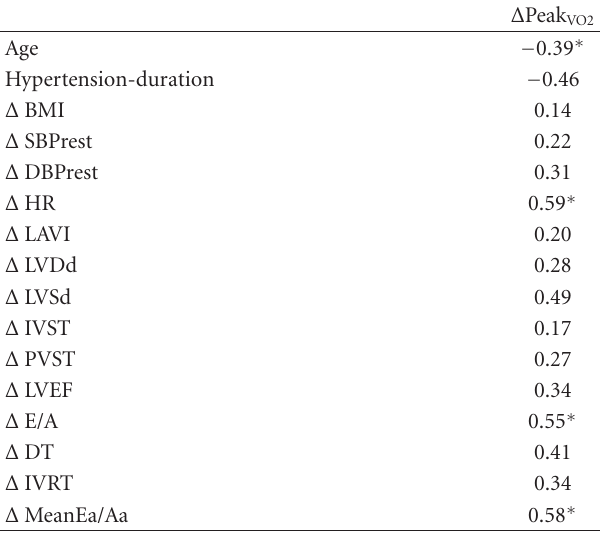
Table 5: Univariate correlation in exercise group.